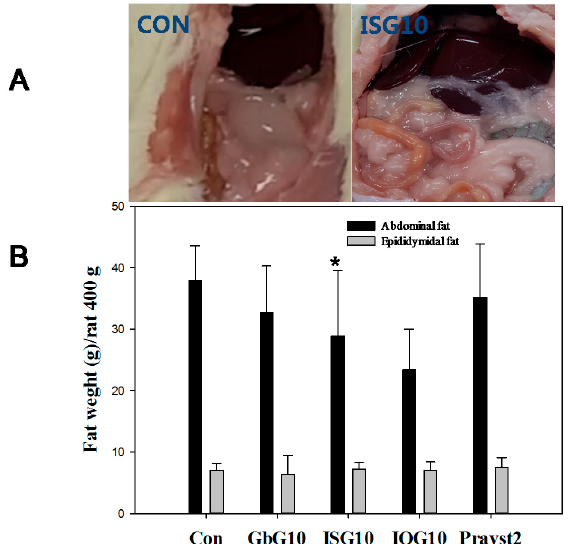
Figure 2. ( A ) Abdominal fat in a Wistar HFD rat. Abdominal fat is shown in the CON (control group) and ISG (ISG10: I. sinclairii glycosaminoglycan 10 mg/kg) groups. ( B ) Effect of IQG or ISG on abdominal and epididymidal fat weight on a high fat diet. * p < 0.05, compared with the control (HFD only) group. GbG10: G. bimaculatus glycosaminoglycan 10 mg/kg. B. ignitus glycosaminoglycan 10 mg/kg. Pravast2: Pravastain 2 mg/kg.